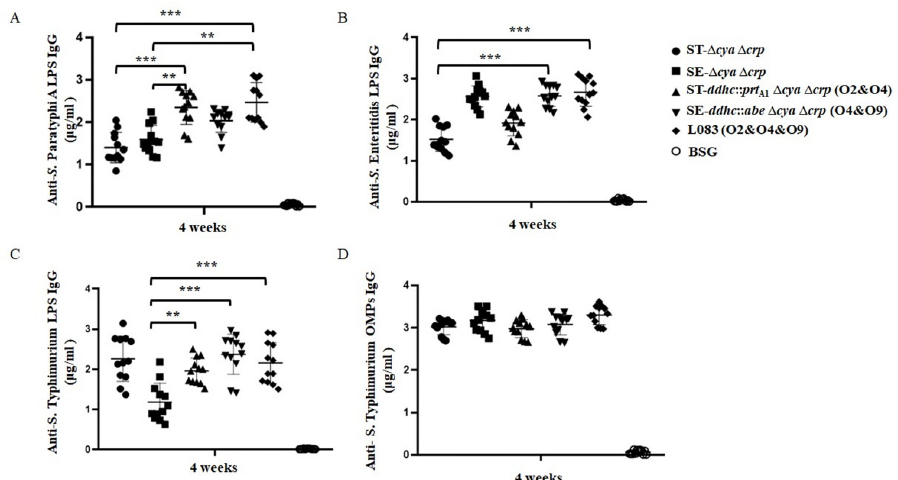
Fig 6. Serum IgG antibody responses. (A) Anti- S . Paratyphi A LPS serum IgG levels. Responses that differed from the results in the ST- Δ cya Δ crp group are noted by asterisks ( �� , P < 0.01; ��� , P < 0.001). (B) The anti- S . Enteritidis LPS serum IgG levels. Responses that differed from the results in the ST- Δ cya Δ crp group are noted by asterisks ( ��� , P < 0.001). (C) Anti- S . Typhimurium LPS serum IgG levels. Responses that differed from the results in the SE- Δ cya Δ crp group are noted by asterisks ( �� , P < 0.01; ��� , P < 0.001). Antibody concentrations were calculated using a standard curve and all the measured sample concentrations were within the standard curve range. The error bars represent the standard deviation of the means calculated by GraphPad Prism software. These data are representative of at least two independent experiments.